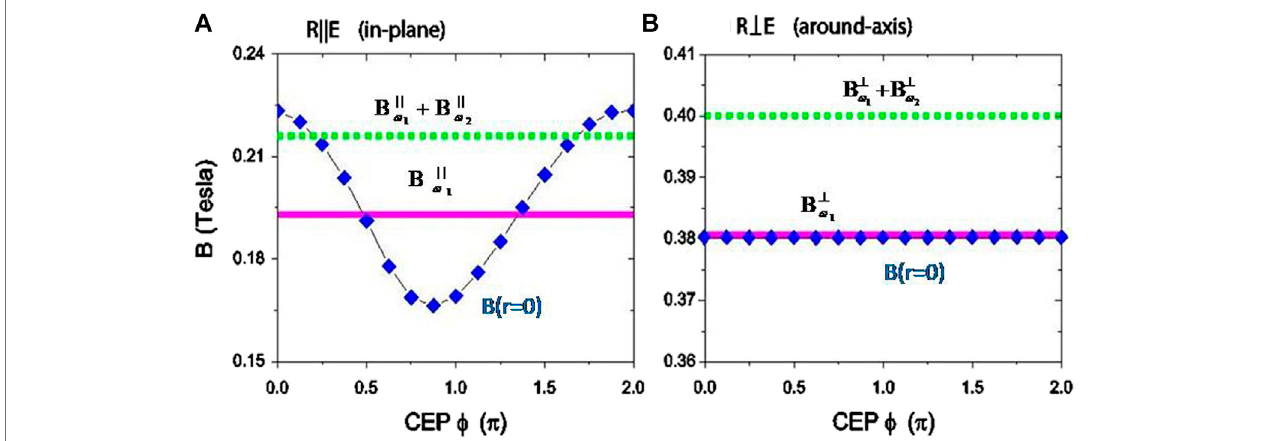
FIGURE 3 | Maximum magnetic fi elds B ( r (cid:1) 0 ) (blue diamond) at the molecular center as a function of CEP ϕ (cid:1) ϕ 2 - ϕ 1 for the aligned molecule H + 2 in bichromatic counter-rotating ( ϵ (cid:1) − 1) circularly polarized laser pulses with their fi eld vectors polarized in the ( x , y ) plane. Two cases are compared for the molecule aligned along (A) the x axis, in plane R (cid:3) E , and (B) the z axis, around axis R ⊥ E . Pulse wavelengths λ 1 (cid:1) 70 nm ( ω 1 (cid:1) 0 . 65 au) and λ 2 (cid:1) 35 nm ( ω 2 (cid:1) 1 . 3 au), intensities I (cid:1) 1 × 10 14 W/cm 2 ( E (cid:1) 0 . 0534 au), and duration T lp (cid:1) 5 τ 1 (cid:1) 10 τ 2 (580 as FWHM) are fi xed. Red solid lines denote the generated magnetic fi eld B (cid:3) ω (cid:1) 0 . 382 Tbyasingle λ (cid:1) 70 nmcircularly polarized laserpulse, and greendashed lines present the sum valuesofthe magnetic fi elds B (cid:3) and B ⊥ ω 1 and B